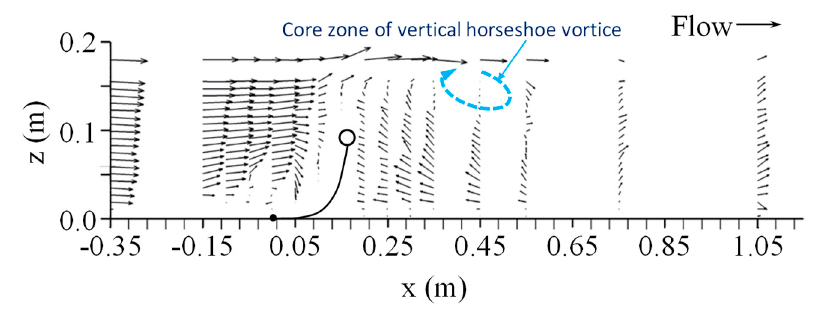
Figure 9. Velocity vectors on streamwise center line.